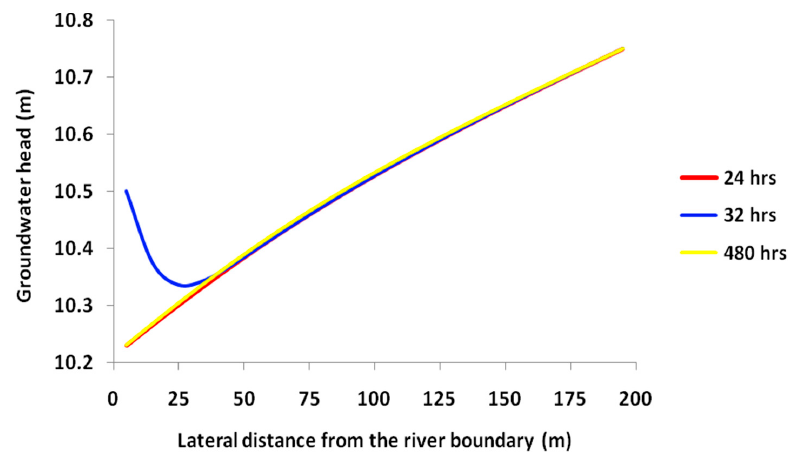
Figure 13. STRIVE simulated groundwater head versus lateral distance from the river-aquifer boundary at 100 m (near to the upstream model boundary in longitudinal direction of the river), at times 24, 32, and 48 h, using a hydrodynamic river boundary with a transient state simulation.